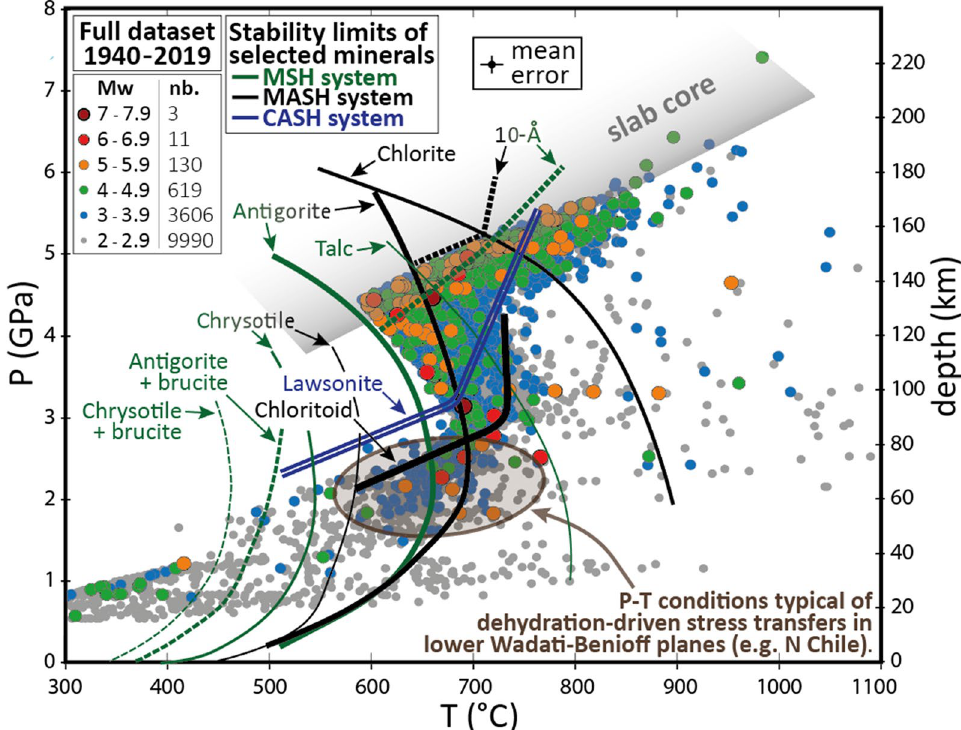
Figure 3. Pressure and temperature at hypocenters beneath Vrancea. P–T conditions at hypocenters from 20 to 240 km depth, highlighting the “S” shape of Vrancea intermediate-depth seismicity. At first order, three main trends are observed: (1) 30–80 km: P–T conditions consistent with relatively warm subducting oceanic mantle (lower Wadati-Benioff plane, N Chile 12 , (2) 80–170 km: P–T conditions consistent with serpentine dehydration (negative Clapeyron slope) in relatively warm subducting mantle (mostly antigorite) and (3) 170–240 km: P–T conditions consistent with the center (coldest part) of a relatively warm subducting slab, which could be consistent with the dehydration of either the 10-Å phase (Fig. 4a) and phase A (Fig. 4b), i.e. mantle, or lawsonite (Fig. 4c). For a detailed review of mineral destabilizations considering either mantle or crust, see Fig. 4. For chemical formula, see Table S1. Error bars indicate the mean uncertainties, which are 0.22 GPa in pressure (6.5 km in depth) and 25 °C in temperature. Abbreviations: MSH = MgO-SiO 2 -H 2 O; MASH = MgO-Al 2 O 3 -SiO 2 - H 2 O; CASH = CaO-Al 2 O 3 -SiO 2 -H 2